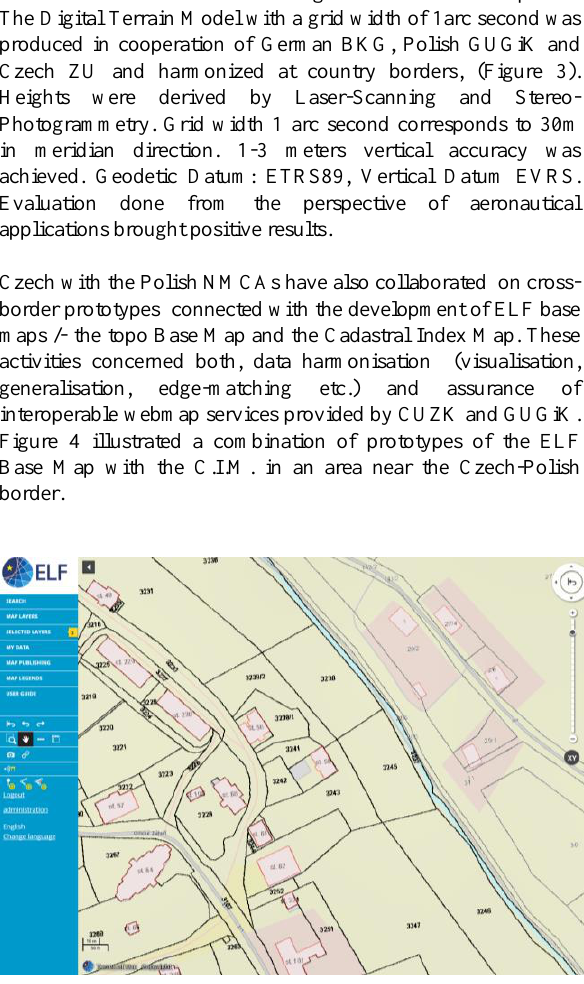
Figure 4. Cadastral Index Map (C.I.M.) underpinned by the ELF topo Base Map – Czech-Polish